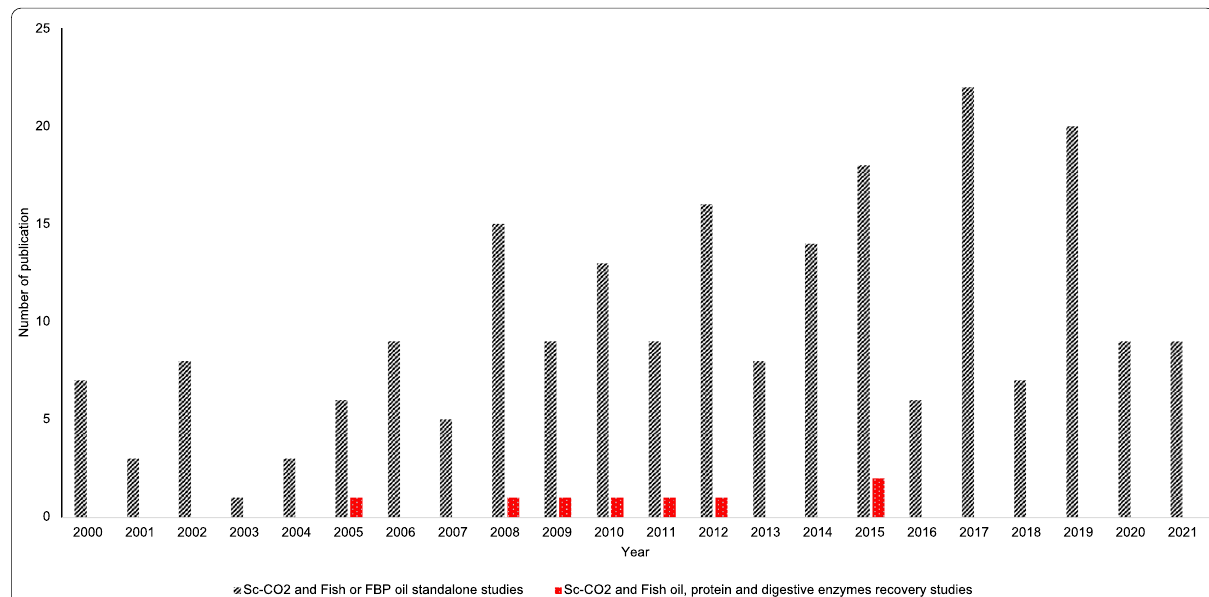
Fig.1 Published journal articles related to Sc-CO 2 , fish oil, recovery of protein, and enzymes from